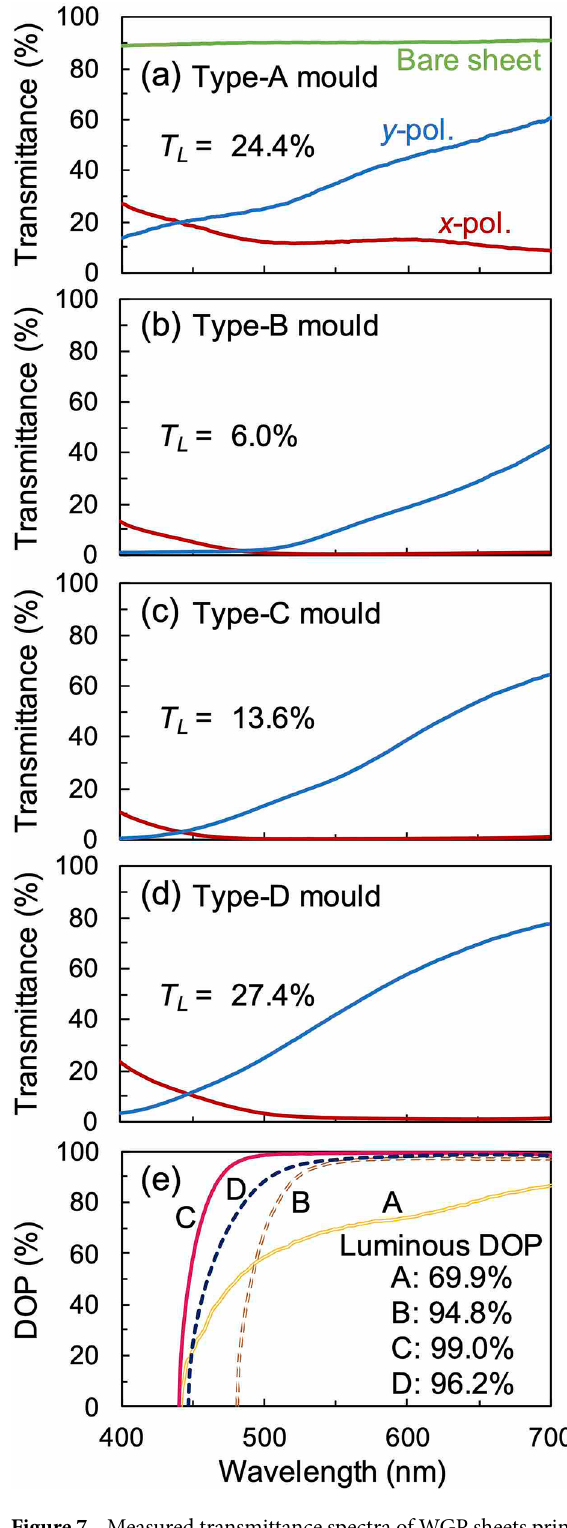
Figure 7. Measured transmittance spectra of WGP sheets printed by using ( a ) type-A, ( b ) type-B, c type-C, and ( d ) type-D moulds. ( e ) DOP spectra were obtained from the measured transmission spectra of each